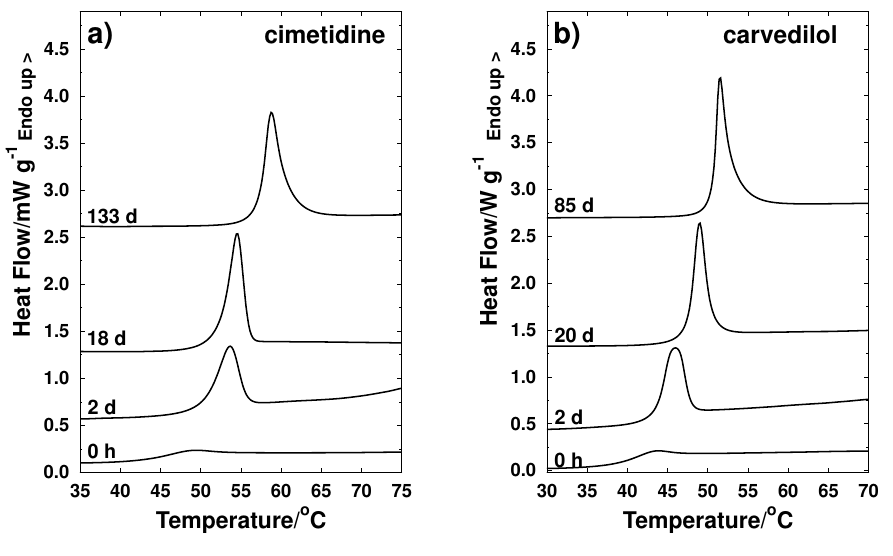
Figure 5. Behavior of glass transition temperature as a function of storage time (days) for amorphous pure active ingridients: ( a ) cimetidine; ( b ) carvedilol.